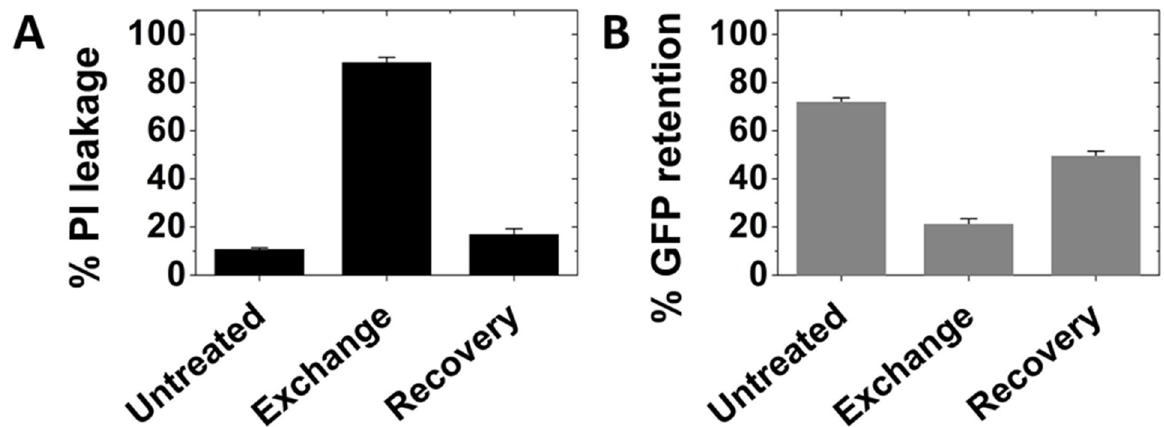
Fig 7. Recovery minimizes the loss of membrane integrity after lipid exchange. CHO cells were transfected with eGFP expression plasmid 1d before exchange at conditions sub-optimal for maintaining membrane integrity. A. PI leakage and B. GFP retention analyzed by flow cytometry in untreated cells, immediately after exchange, or after a 2h recovery step. Exchange was carried out in 3.5 cm diameter plates at 37˚C with 1 ml of 3 mM SM plus 50 mM M α CD. Recovery was carried out at 37˚C in the same plates with 1.5 ml of complete growth medium. Mean and standard deviation from three experiments is